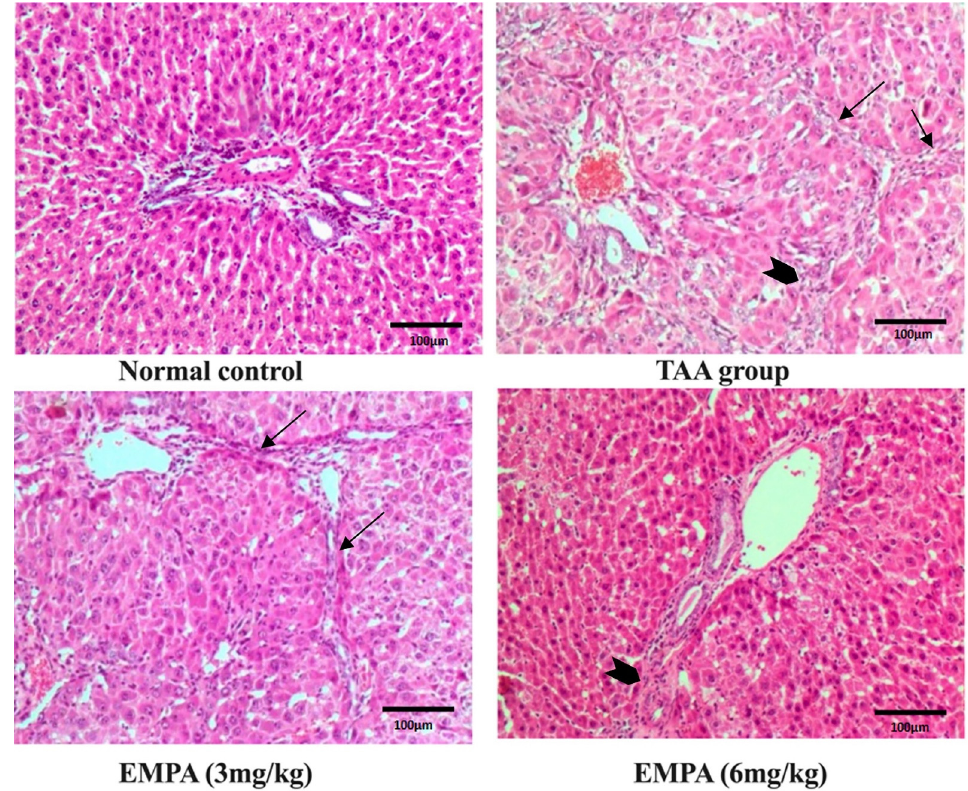
Figure 4. Photomicrographs of histopathology sections stained with hematoxylin and eosin. Normal histology of the control group, moderate inflammation (arrow head) and marked fibrotic septa with complete cirrhotic nodule formation (thin arrows) in the toxic group, marked regression in inflammatory cell infiltrate however, minimal regression of fibrosis (thin arrows) in 3 mg group, excellent regression of both inflammatory cell infiltrate and fibrotic process in 6 mg group (arrow head) (magnification = 200×).